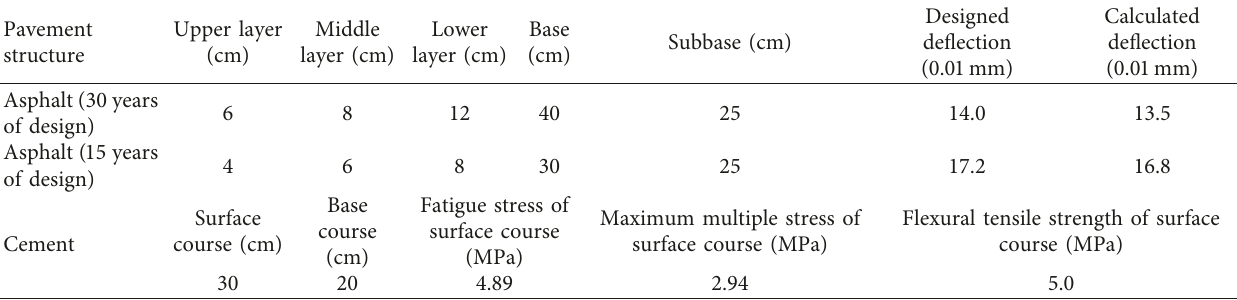
Table 3: Design parameters of pavement structure.